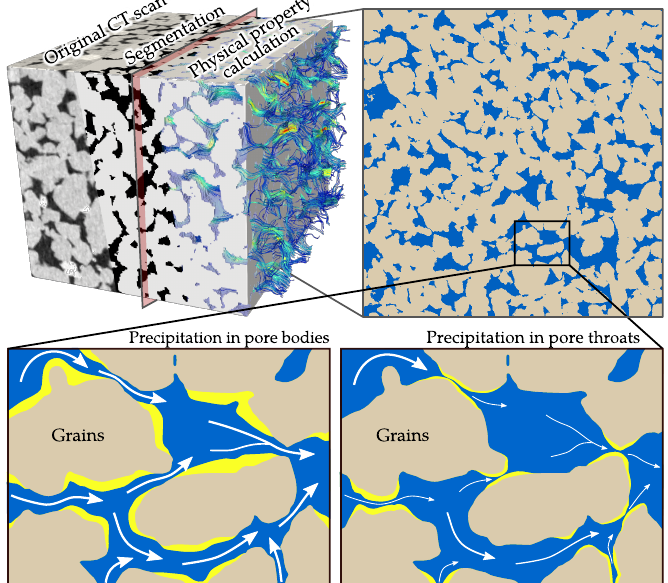
Figure 1. The typical workflow in digital rock physics comprises imaging, segmentation and numerical computation of the rock properties. In view of a virtual laboratory, varying testing conditions or distributions of secondary minerals can be examined for the same sample, e.g., to investigate the effect of spatial precipitation patterns on the evolution of flow